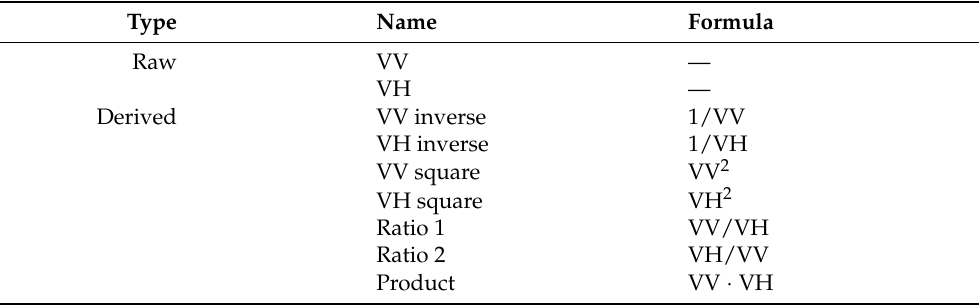
Table 1. Sentinel-1 predictor variables used in Random Forest classification and regression models.